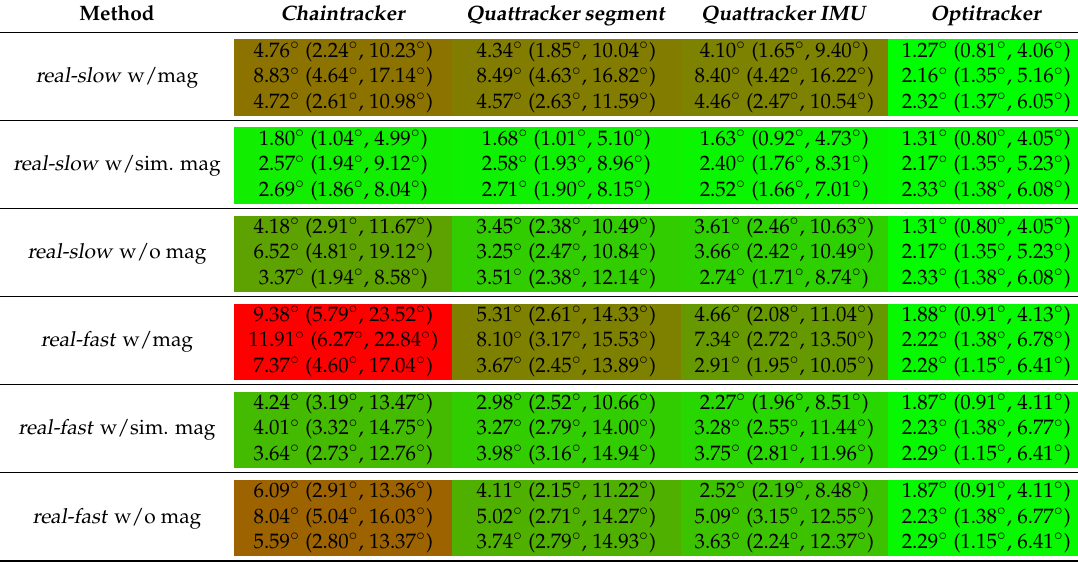
Table 7. Real data scenario: mean (std; max) angular errors for each segment. Note, the color represents a linear interpolation of the mean error over all segments between red (maximum error) and green (minimum error). This helps comparing the performances of the different sensor fusion methods. Also note, w/mag refers to using the real magnetometer measurements, w/sim. mag refers to using the simulated magnetometer measurements (cf. Section 2.6.2) and w/o mag refers to dropping the magnetometer